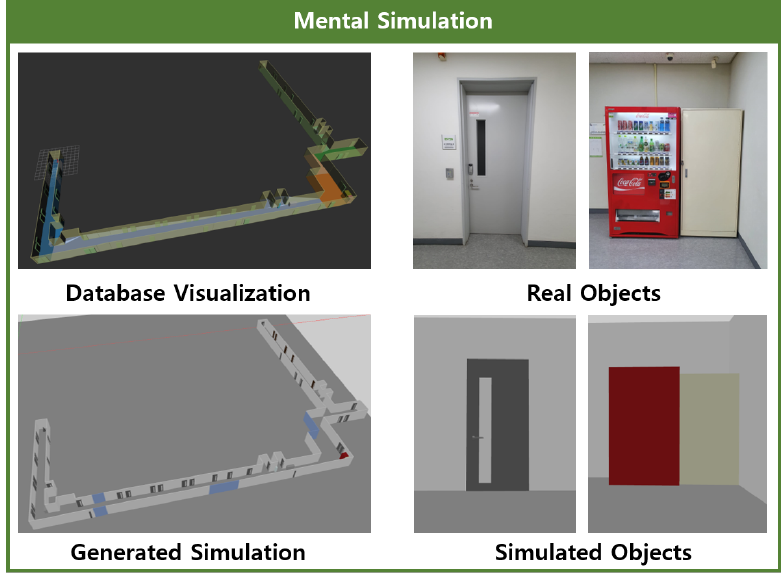
Figure 8. Example environment generated by the mental simulation building